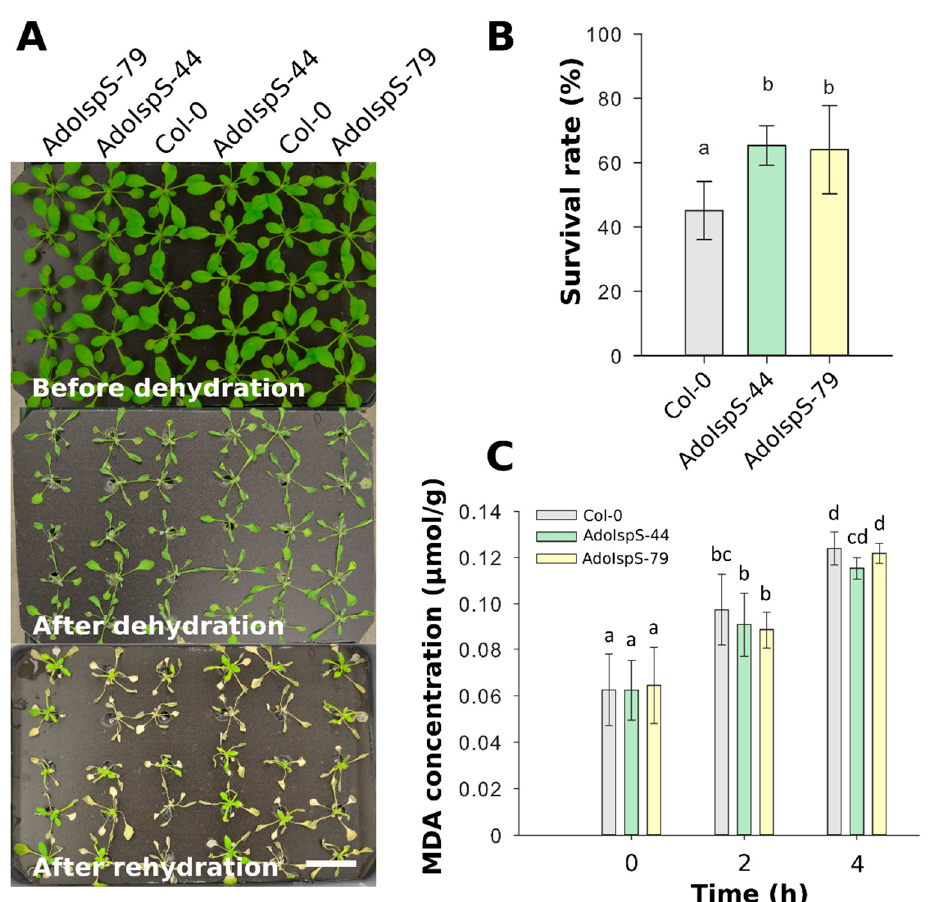
Figure 5. Water-stress tolerance of Arabidopsis plants overexpressing AdoIspS . ( A ) Drought resistance of Col-0 and AdoIspS transgenic plants. Plants were directly exposed to air for 24 h to induce dehydration. After rehydration for 48 h, the representative images were taken (Scale bar = 3 cm), and ( B ) the percentage of plants that survived was determined. ( C ) Lipid peroxidation was assessed by MDA accumulation at different time points. Histogram bars marked with the same letter do not significantly differ from each other (Tukey–Kramer test, p > 0.05). Line bars represent the SD of the means.